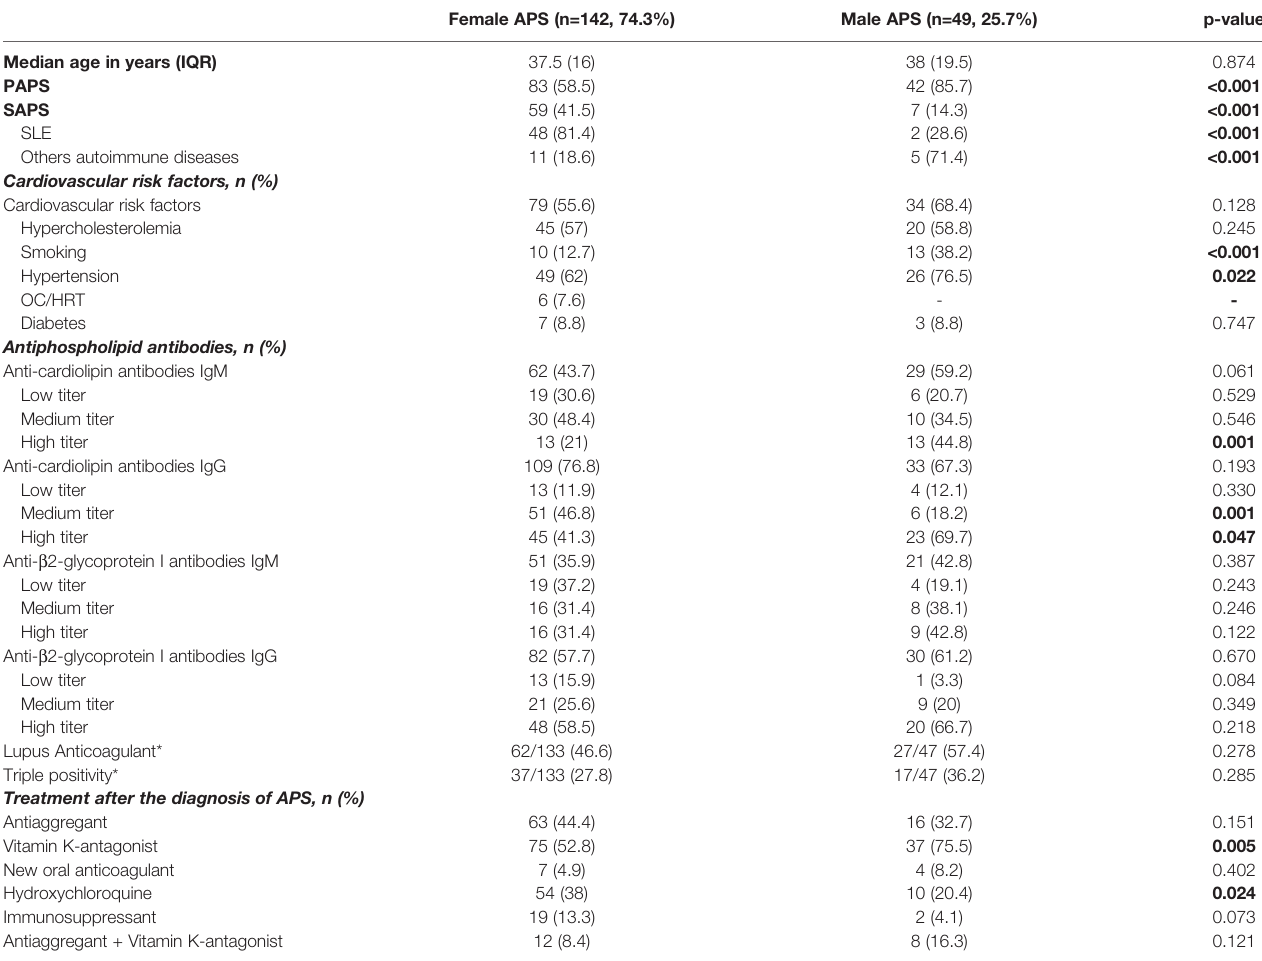
TABLE 1 | Difference between female and male patients with